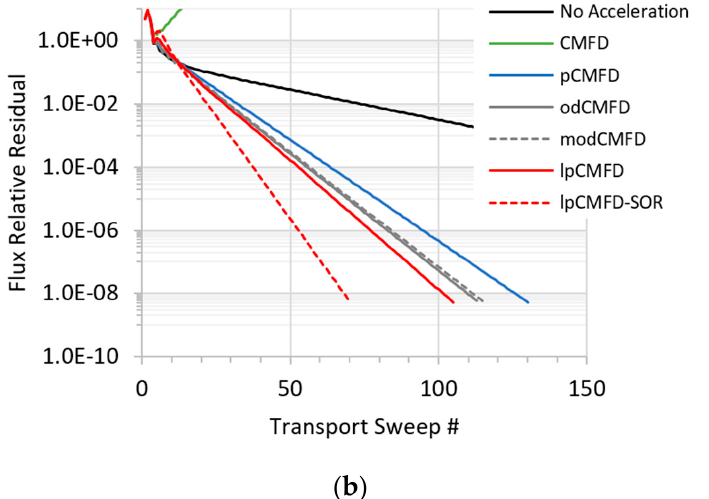
Figure 11. Results of the 2D mini-assembly problem. ( a ) Converged scalar flux; ( b ) convergence comparison.